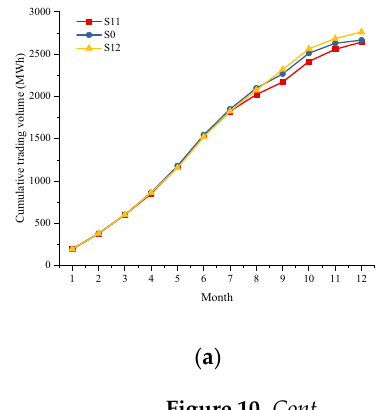
Figure 10a,d show trends of accumulative trading volume and monthly trading vol- ume of renewable